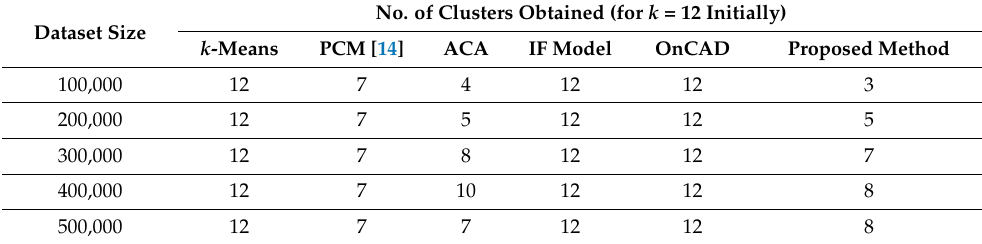
Table 4. Comparative analysis of output clusters using KDDCUP’99.